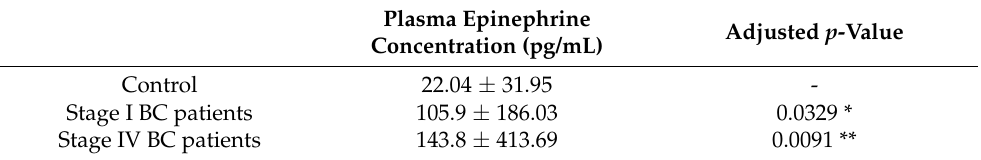
Table 2. Epinephrine plasma levels of control individuals and BC patients at different stages of